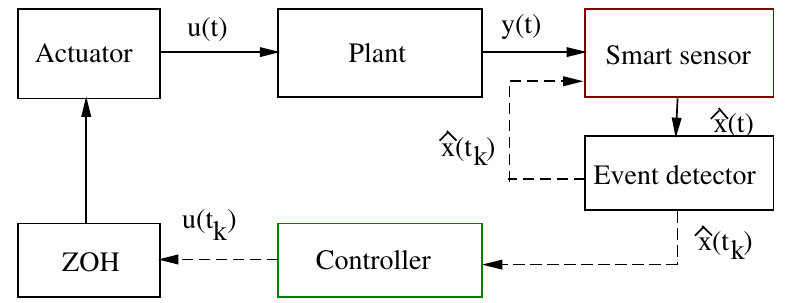
Figure 1. A controlled system, using a smart sensor and based on event-driven observer design: ( 1 ) solid line for continuous-time data, and ( 2 ) dotted line for discrete-time